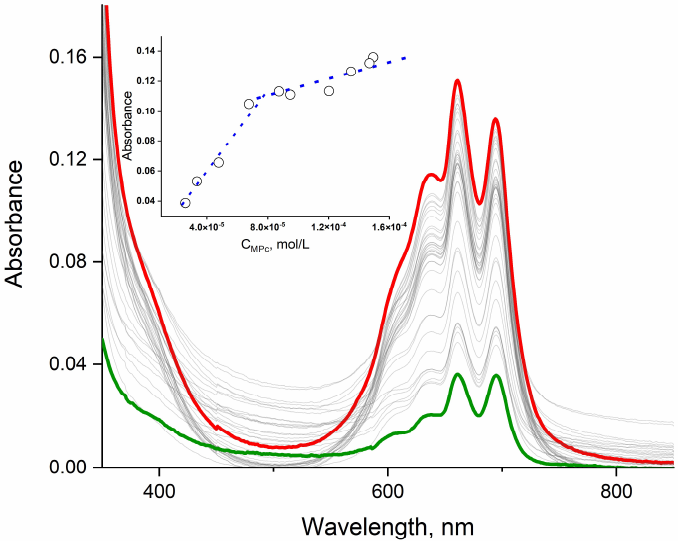
Figure 3. The dilution of compound 6 in acetone solution at the concentration range of 5.58 × 10 − 6 ÷ 1.9 × 10 − 6 mol/L (red curve—initial spectrum; green curve—final spectrum).